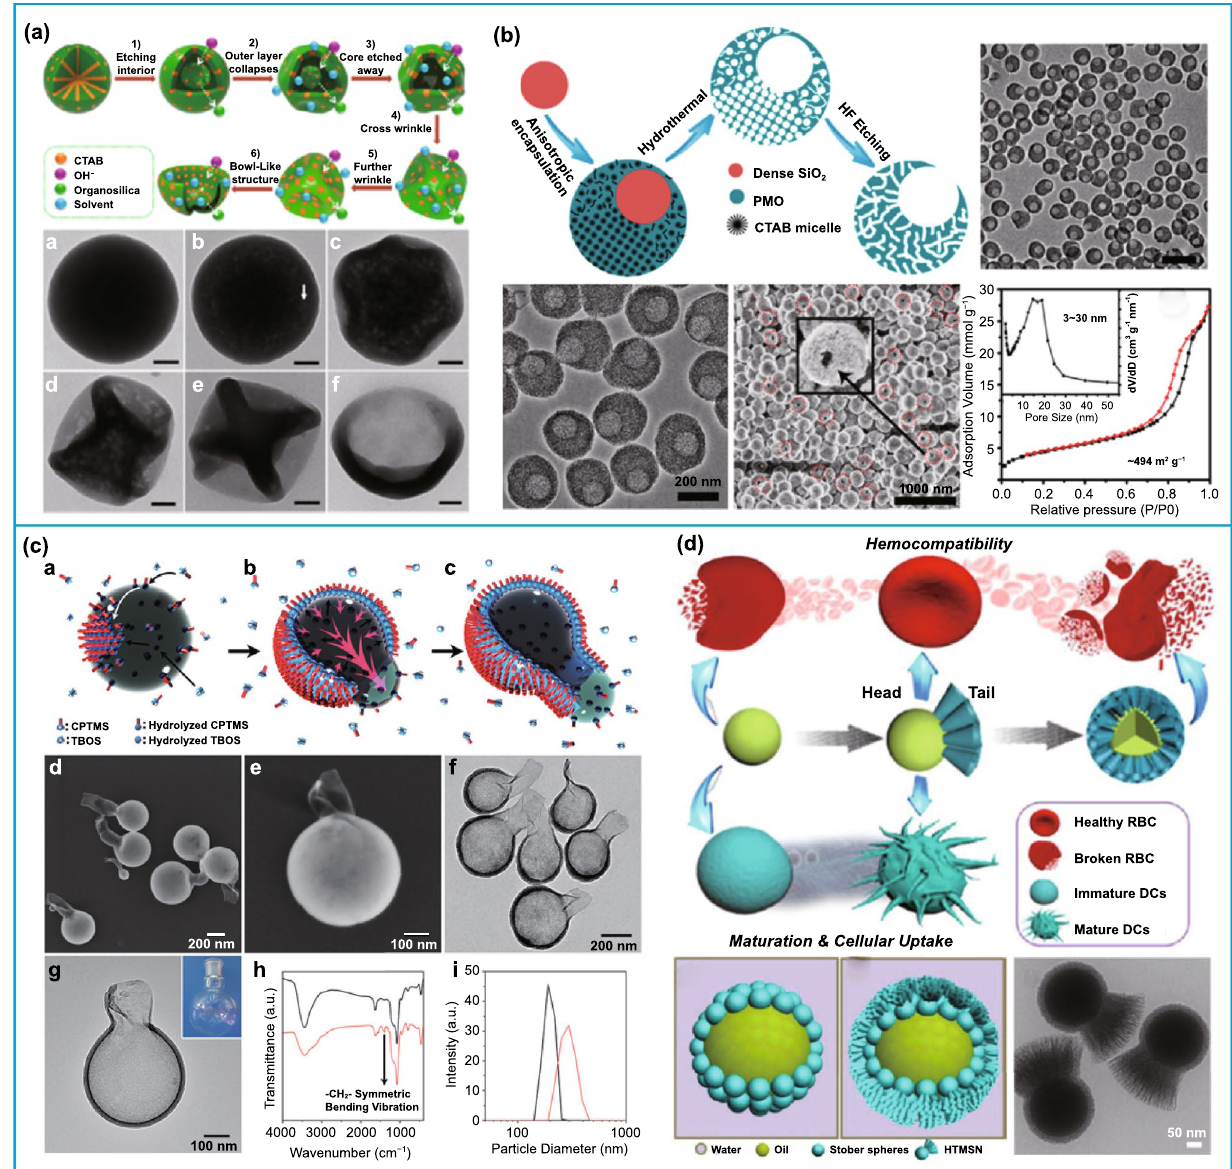
Fig. 7 Various synthetic strategies for preparation of asymmetric pure silica nanoparticles. a Alkali etching destroys the rigid structure of the silica and results in a bowl-shaped silica material. Reproduced with permission from Ref. [78]. Copyright 2017, American Chemical Society. b Fabrication of open-structured silica nanoparticles through chemical etching. Reproduced with permission from Ref. [80]. Copyright 2015, American Chemical Society. c Preparation of bottles-like silica nanoparticles through two-phase interface control. Reproduced with permission from Ref. [81]. Copyright 2016, American Chemical Society. d Fabrication of badminton-like structure through two-phase interface control. Reproduced with permission from Ref. [82]. Copyright 2017, American Chemical